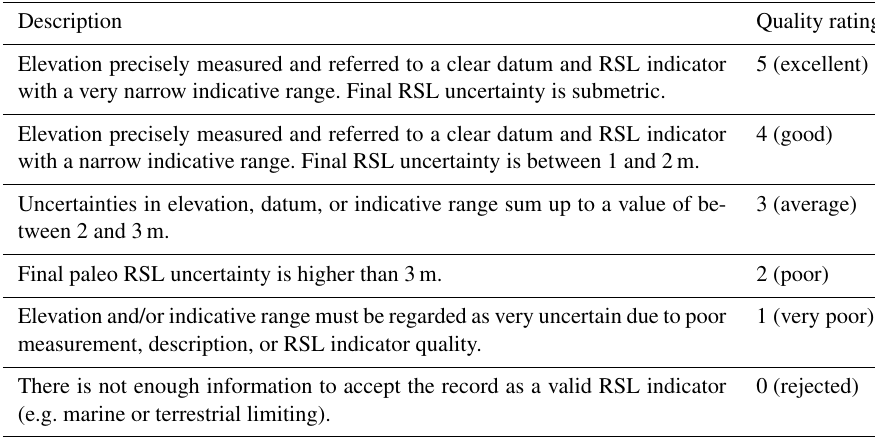
Table 5. Quality scores for age, from the WALIS documentation. Description Quality rating Very narrow age range, e.g. a few thousand years, that allows the attribution to a specific timing within a substage of MIS 5 (e.g. 117 ± 2ka Narrow age range, allowing the attribution to a specific substage of MIS 5 (e.g. MIS 5e) The RSL data point can be attributed only to a generic interglacial (e.g. MIS 5) Only partial information or minimum age constraints are available Different age constraints point to different interglacials tocene